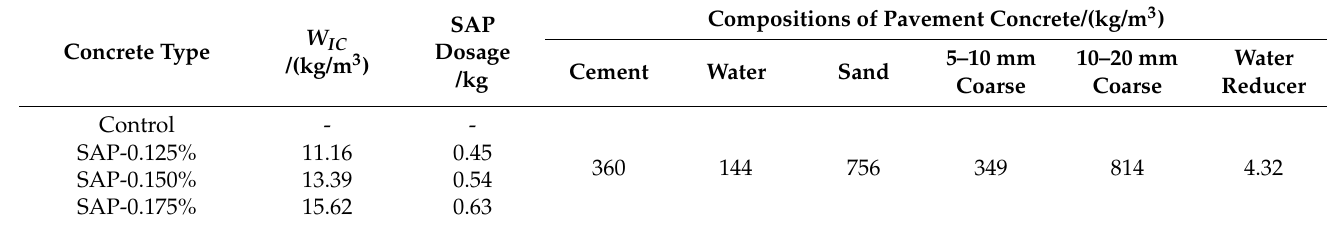
Table 6. Mix proportion of internal curing pavement concrete after